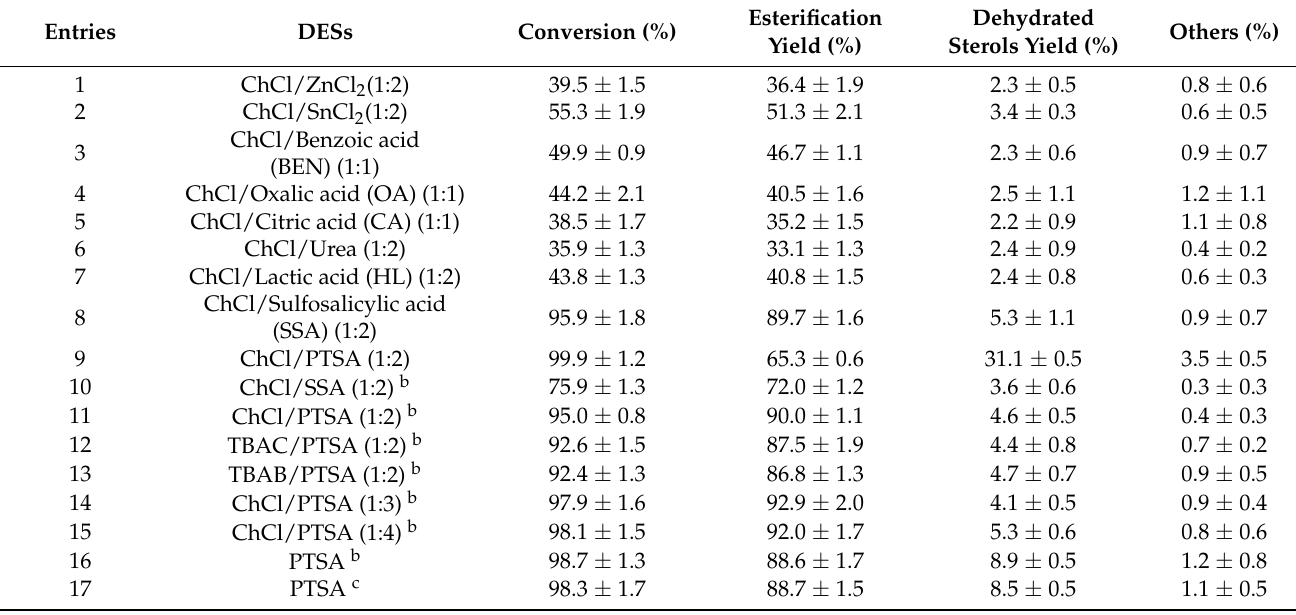
Table 1. Catalytic effect of different DESs a